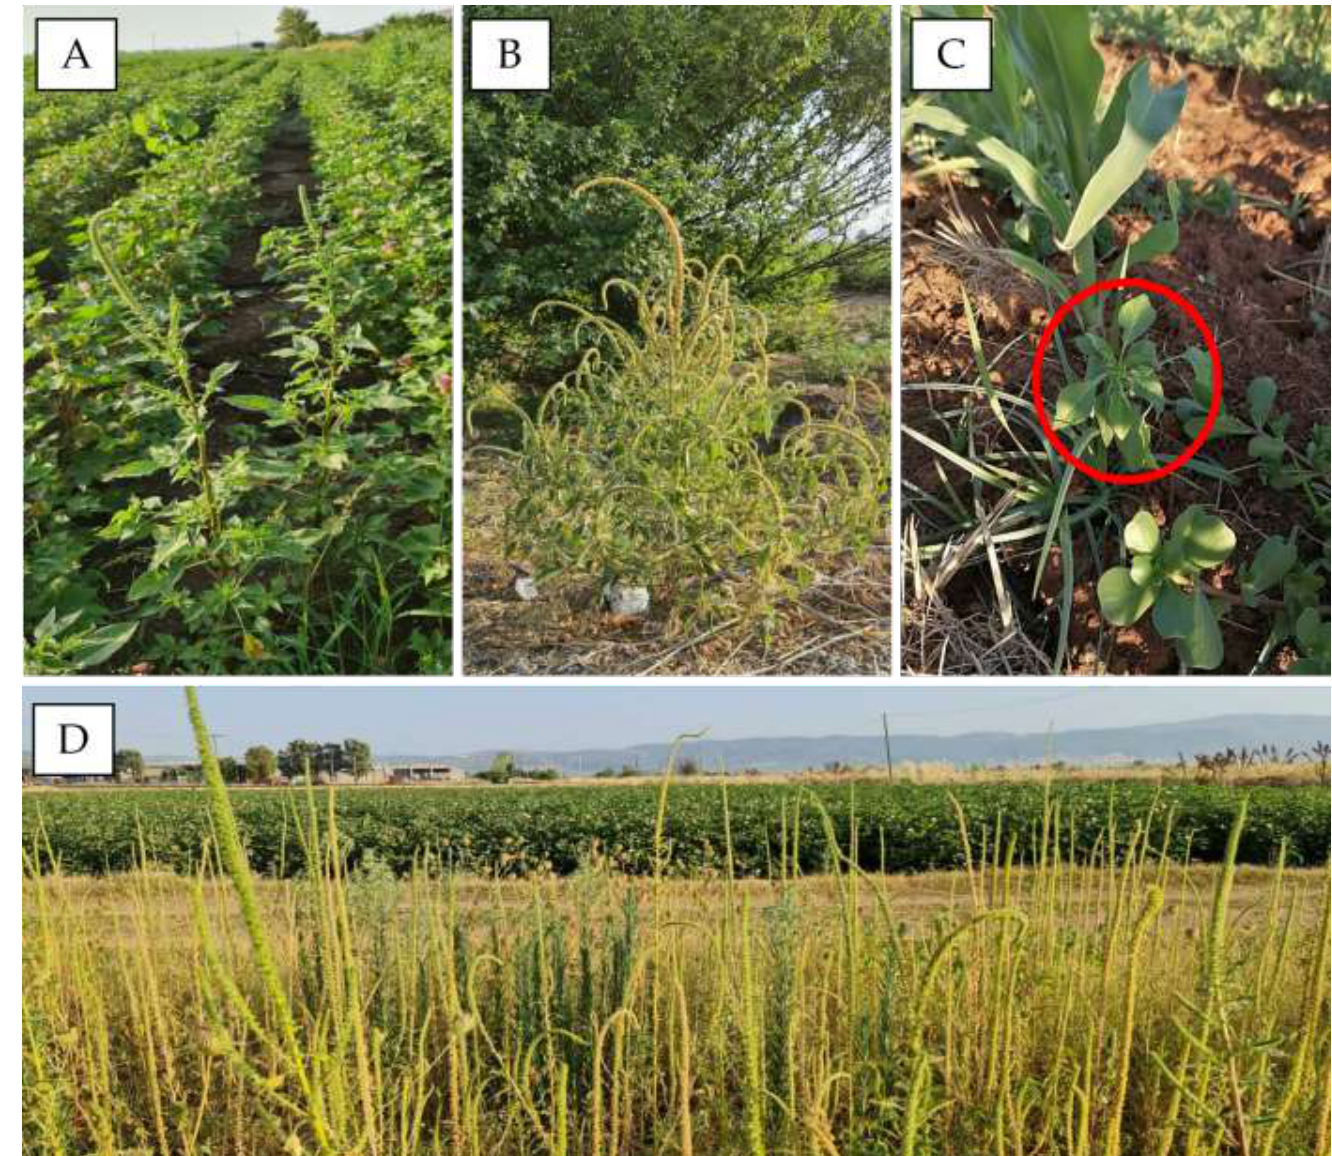
Figure 2. Palmer amaranth infestations in cotton ( A ), maize ( C ) and field margins ( B , D ).